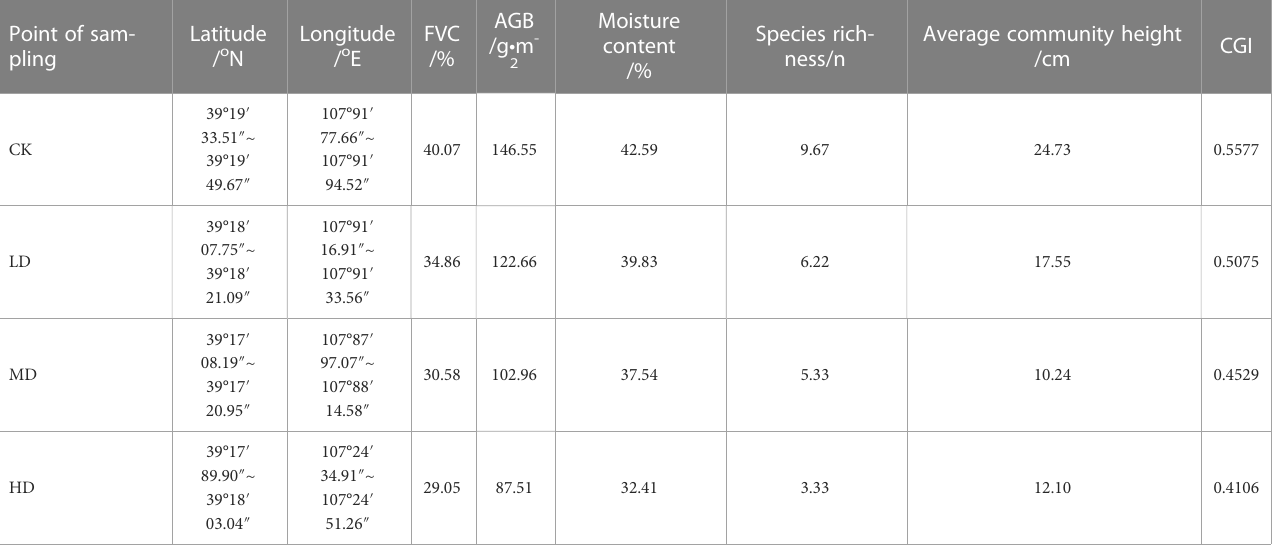
Figure 7B. The boxes indicate the positions of the marked characteristic bands. RMSE decreases rapidly with the increase in the number of characteristic bands. When the number of characteristic bands was 3, the RMSE reached a minimum value of 0.068465. However, to facilitate the subsequent construction of the dual-band spectral index and improve the computational speed, the number of characteristic bands was set to 2. At this point, the RMSE value was 0.084482, which is a difference of 0.016017 from the RMSE value when the number of characteristic bands was 3. Therefore, two characteristic bands were selected as the best band combination. Figure 7C illustrates the results of the selection of characteristic bands. The red squares indicate the positions of the characteristic bands (53 and 108) screened out by the SPA algorithm after preprocessing, and the wavelength combination is 658 nm and 878 nm, distributed in the red light range and the near-infrared spectral range, respectively. (3) Spectra Screened by the OIF The number of band combinations obtained from OIF was larger. Only the fi rst fi ve OIF values are listed in Table 3, showing that the OIF value of the wavelength combination of 450 nm and 942 nm is the highest (0.1033). The correlation coef fi cient is the lowest at 0.2884, which is signi fi cantly lower than that of the other four band